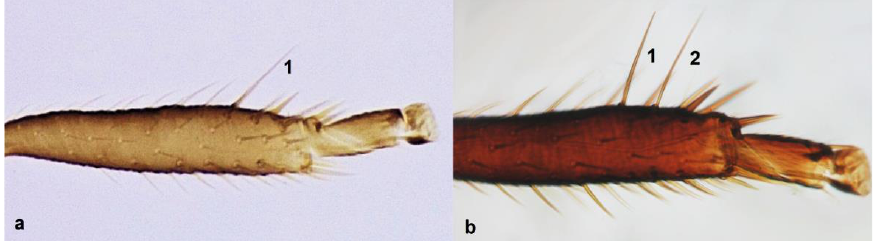
Figure 15. Hind tibia: ( a ) with one long seta; ( b ) with two long setae. 15 Antennae nine-segmented (Figure 16a); antennal segments III and IV with cone- shaped sensoria (Figure 3g) …………………………. Stenurothripidae …………………………………………………….. Holarthrothrips tenuicornis Priesner Antennae six-, seven-, or eight-segmented (Figure 16b,d); antennal segments III and IV with sensoria consisting of a single (simple or hair-like) (Figure 3h) or forked filamentous structure (Figure 31) ................................................................ Thripidae .. 16 Diversity 2023 , 15 , x FOR PEER REVIEW